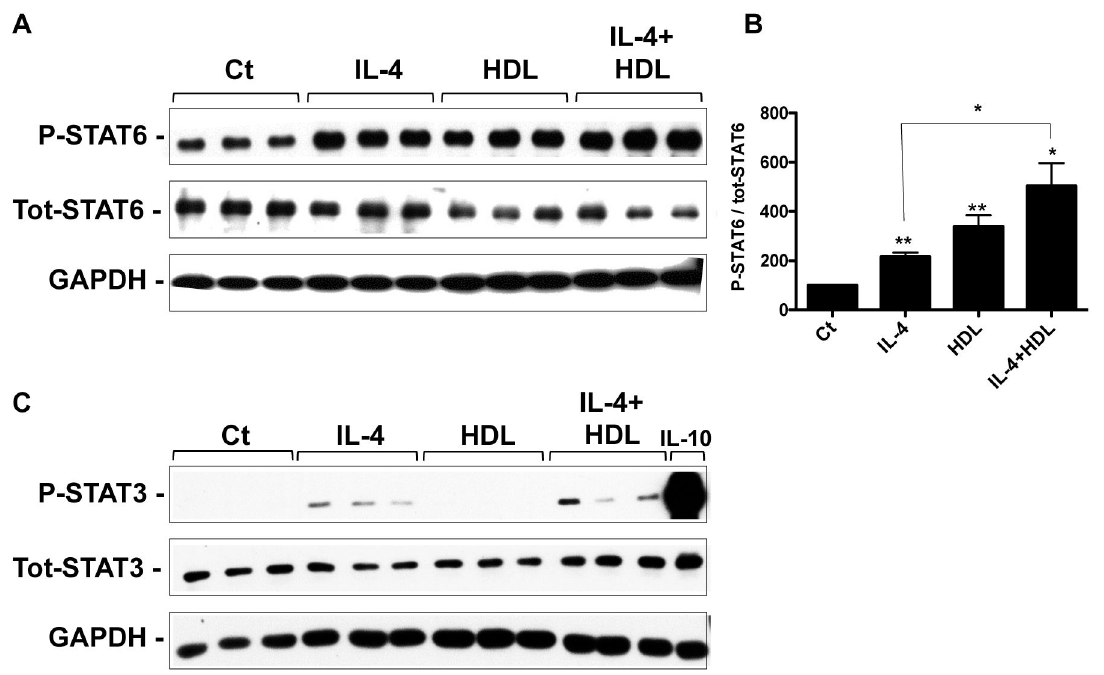
Figure 3. HDL induces STAT6 phosphorylation and enhances IL-4-induced STAT6 activation, but has no effect on STAT3 phosphorylation status. BMDM were grown as previously described and stimulated for 15min with either HDL alone (50μg/mL), IL-4 alone (10ng/mL) or both. Phosphorylation state for STAT6 (A) and STAT3 (C) was assessed by western blot. As a positive control for STAT3 activation, cells were treated with IL-10 (10ng/mL) for 30 min. Signal quantification for phospho-STAT6 (B) is the result of three independent experiments. Asterisks indicate statistically significant difference, either compared to control, or between 2 conditions when linked by a bar (*p<0.05,